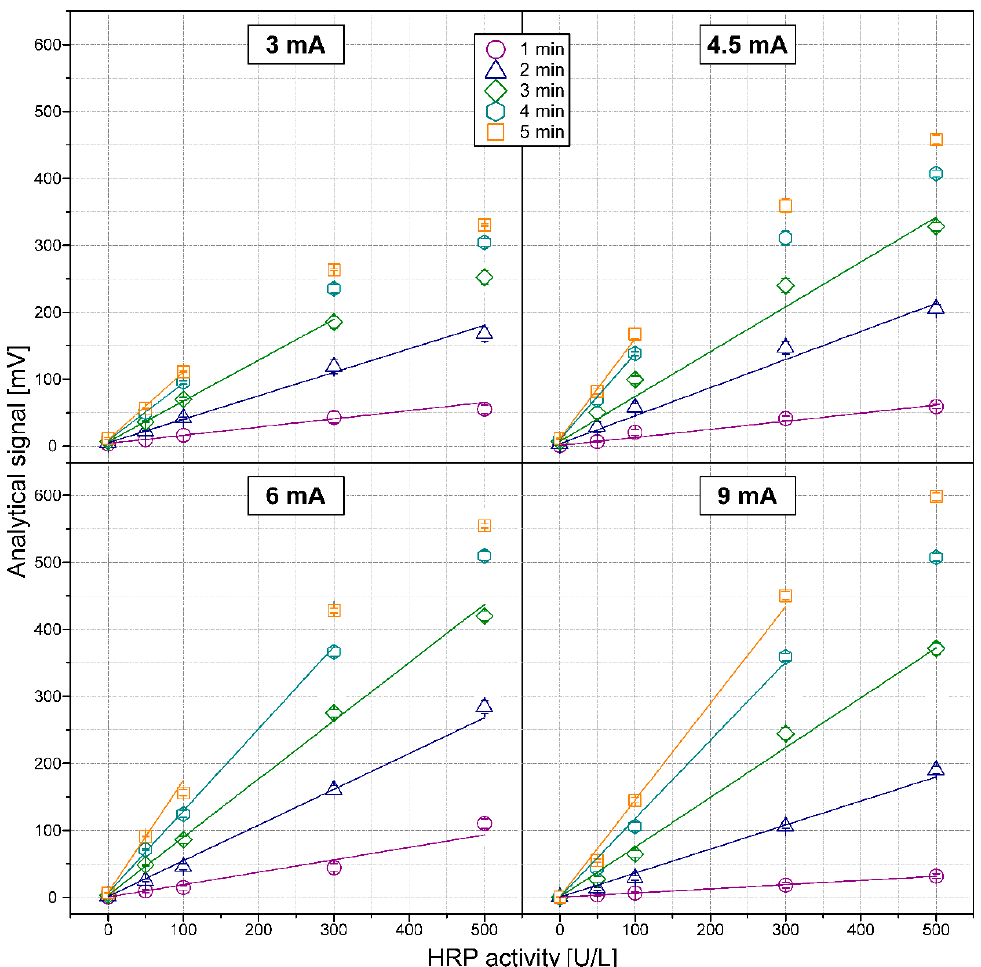
Figure 2. The detector responses for HRP activity in the range of 0–500 U/L depending on the currents supplying the emitter. The results are presented as analytical signals obtained for various incubation times. Error bars represent one standard deviation for n = 3.